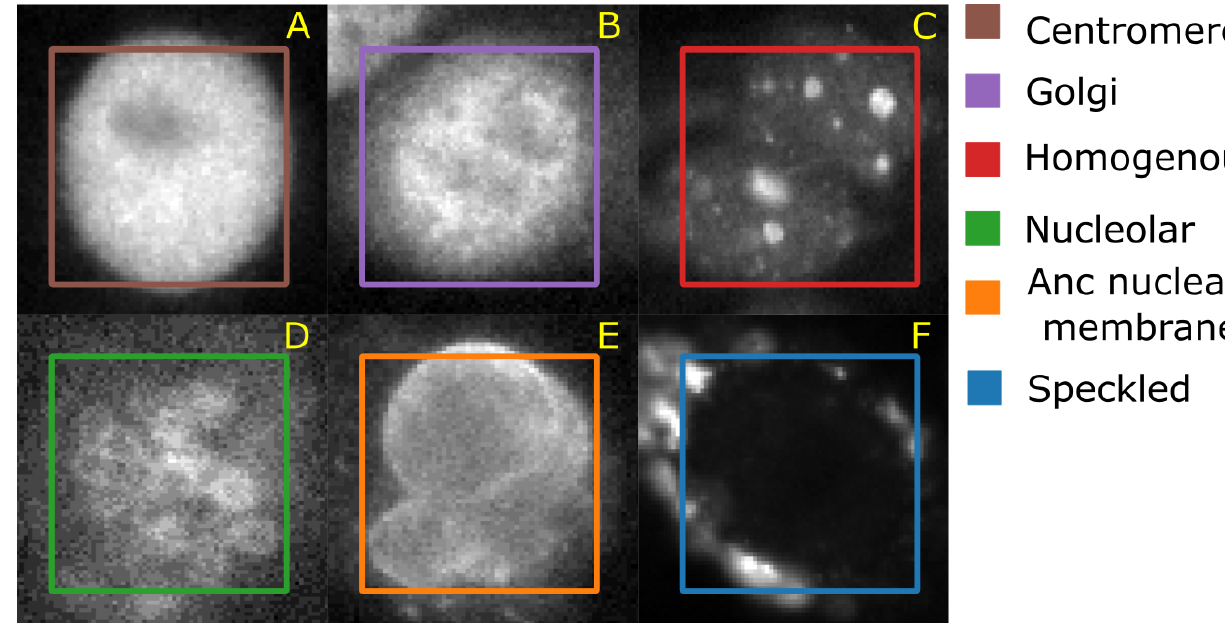
Figure 6. A representative image of each cell class and the average number of correctly classified instances in 10 cross validation. ( A ) Centromere (CT); ( B ) Golgi apparatus (GG); ( C ) Homogeneous (HM); ( D ) Nucleolar (NCL); ( E ) Anc nuclear membrane (ANM); ( F ) Speckled